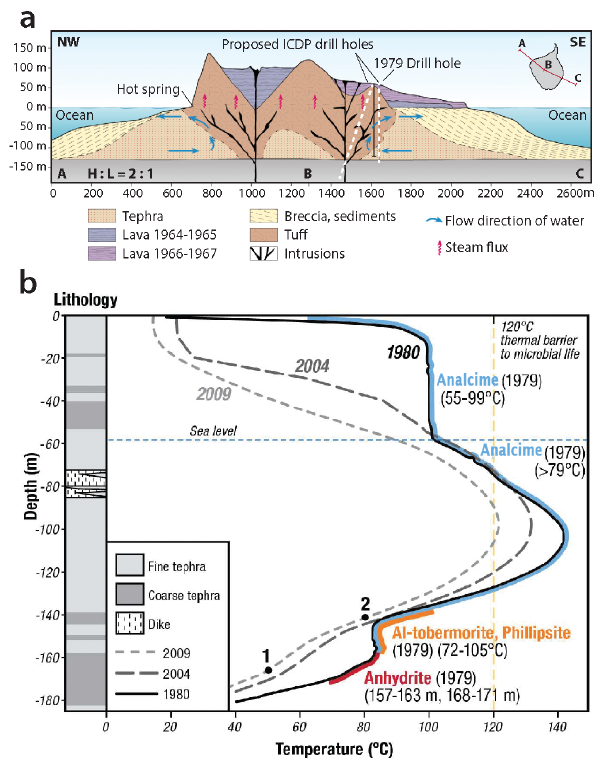
Figure 3. Hydrothermal alteration of Surtsey deposits (after Jack- son, 2014). (a) Schematic cross section (Jakobsson et al., 2009) shows inferred feeder dikes, palagonitization of basaltic tuff in 2004, the 1979 drill hole, and the two planned ICDP drill holes. (b) Temperatures in the 1979 hole. Lines adjacent to the 1980 curve show greatest abundance of authigenic analcite (blue), Al- tobermorite and phillipsite (orange), and anhydrite (red). Down- hole water sampling in 2009 and microbiological analyses re- veal diverse subterrestrial bacterial sequences and Methanobacte- riales blackbox[CE]Please note that when written individually only the “genus” devision names withing the taxonomic clasification sys- tem are italicized, it seems that Methanobacteriales refers to an “or- der” of the system. For future reference, does Methanobacteriales fall under a different set of taxonomy and nomenclature rules?-like archaeal sequences at 172m (54 ◦ C) (site 1) and an archaeal com- munity dominated by Archaeoglobus -like 16S rRNA sequences at 145m (80 ◦ C) (site 2) (Jakobsson and Moore, 1986; Olafsson and Jakobsson, 2009; Marteinsson et al.,